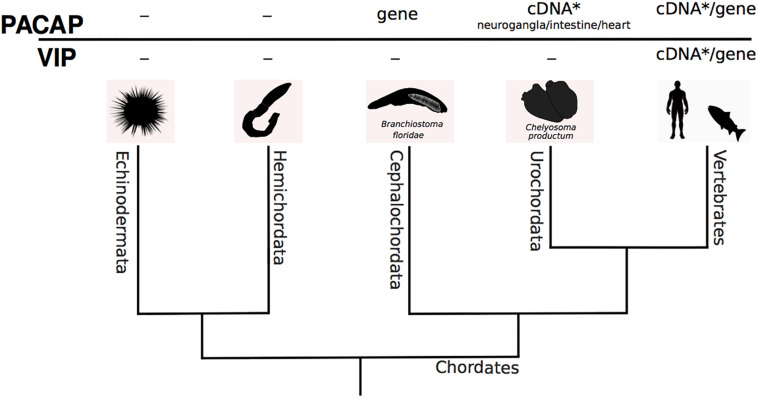
A dendrogram representing the phylogenetic relationship of the invertebrate deuterostome phyla. Available molecular and expression data (PCR and IHC) for putative PACAP and VIP is presented (McRory and Sherwood, 1997). The tissues where putative PACAP or VIP were found are indicated. - no data available; * full-length cDNA.